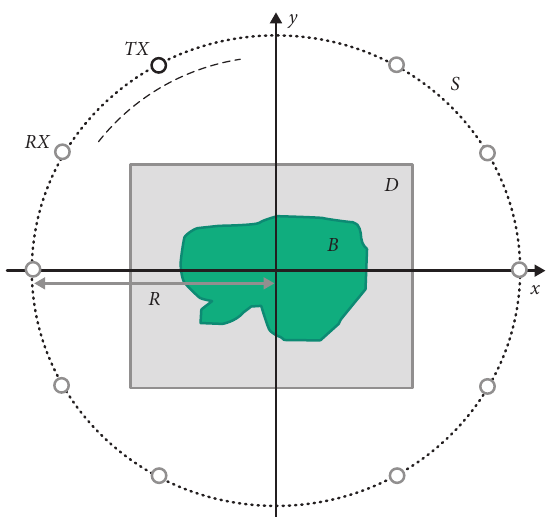
Figure 1: Acquisition setup for